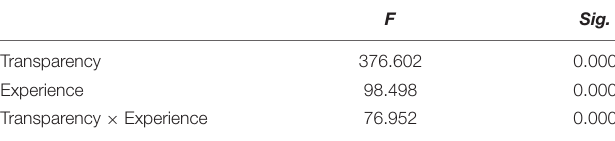
TABLE 2 | ANOVA on effects of transparency and experience.